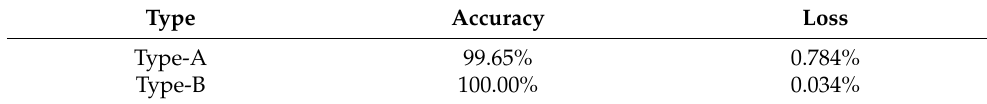
Table 4. Training results for two different types of convolutional neural